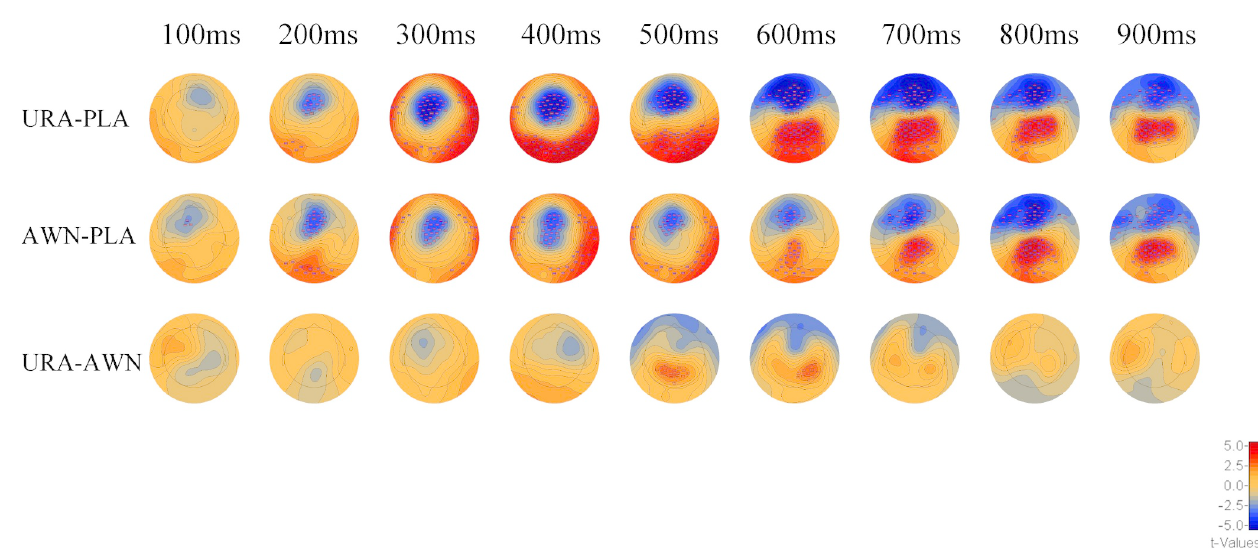
Fig 5. Statistical differences in the FRP amplitude for the first fixation on the target word. The scale depicts differences between the first element of the pair to the second element of the pair in values of the test statistic t. Rectangles signify that the sensor displays a statistically significant difference and belongs to a cluster. The colour of the stars within the squares signifies membership in a specific cluster. PLA = Plausible, URA = Unrelated anomalous and AWN = Anomalous word